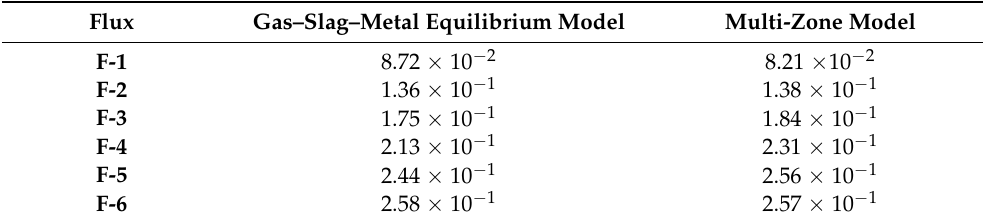
Table 5. MnO activity in the gas–slag–metal equilibrium model and the multi-zone model.